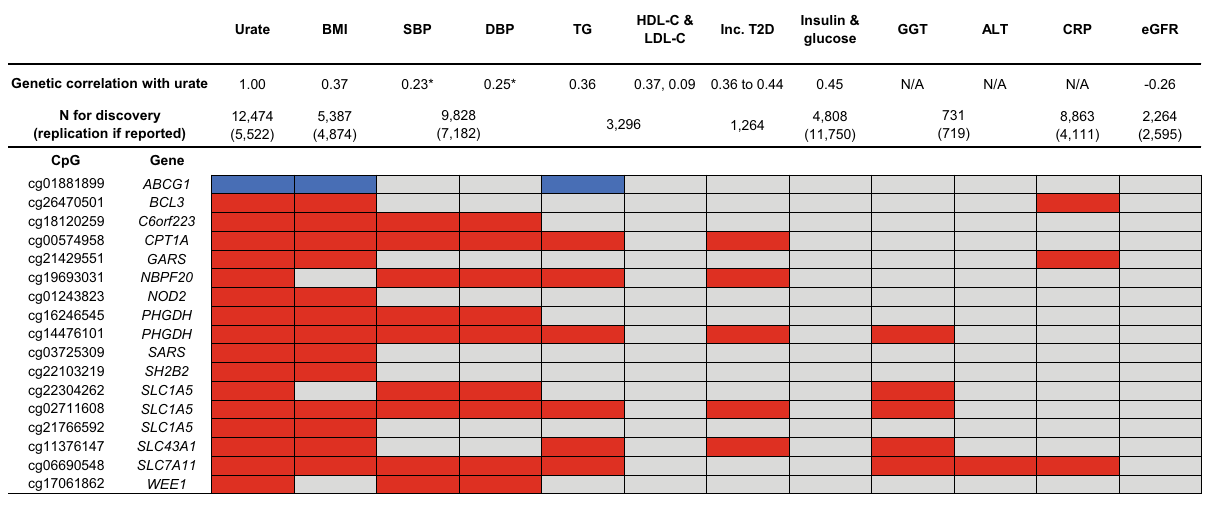
Fig. 8 Urate-associated CpGs that were associated with cardiometabolic and kidney traits. All traits that were included in the lookup are shown, including those without reported associations with urate-associated CpGs. Blue: positive association between DNA methylation and trait levels; Red: inverse association between DNA methylation and trait levels. BMI body mass index, SBP systolic blood pressure, DBP diastolic blood pressure, TG triglycerides, HDL-C high-density lipoprotein cholesterol, LDL-C low-density lipoprotein cholesterol, inc. incident, GGT Gamma-glutamyl transferase, ALT alanine aminotransferase, CRP C-reactive protein, eGFR estimate glomerular fi ltration rate. Genetic correlations were reported in Tin et al. Nat Genet 2019. *Genetic correlation between serum urate and hypertension was 0.39. No EWAS of hypertension was available; SBP and DBP were used